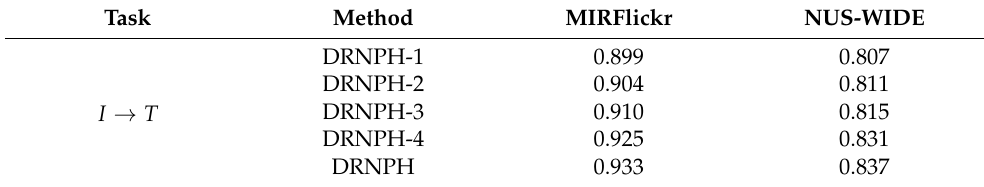
Table 4. The mAP@50 of the image retrieving text task and the number of binary bits is 128. Task Method